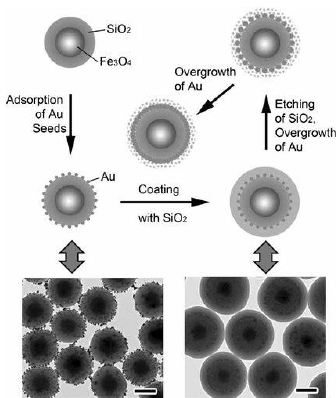
Figure 5. Depiction of stepwise gold nanoshell synthesis using sandwiched gold seeded approach using transmission electron microscopy. Reprinted with permission from Reference [48]. Copyright (2010) John Wiley and Sons.